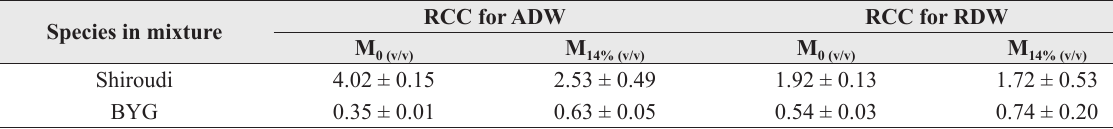
Effect of methanol foliar application on relative crowding coefficient (RCC) for aboveground dry weight (ADW) and root dry weight (RDW) averaged across two years.